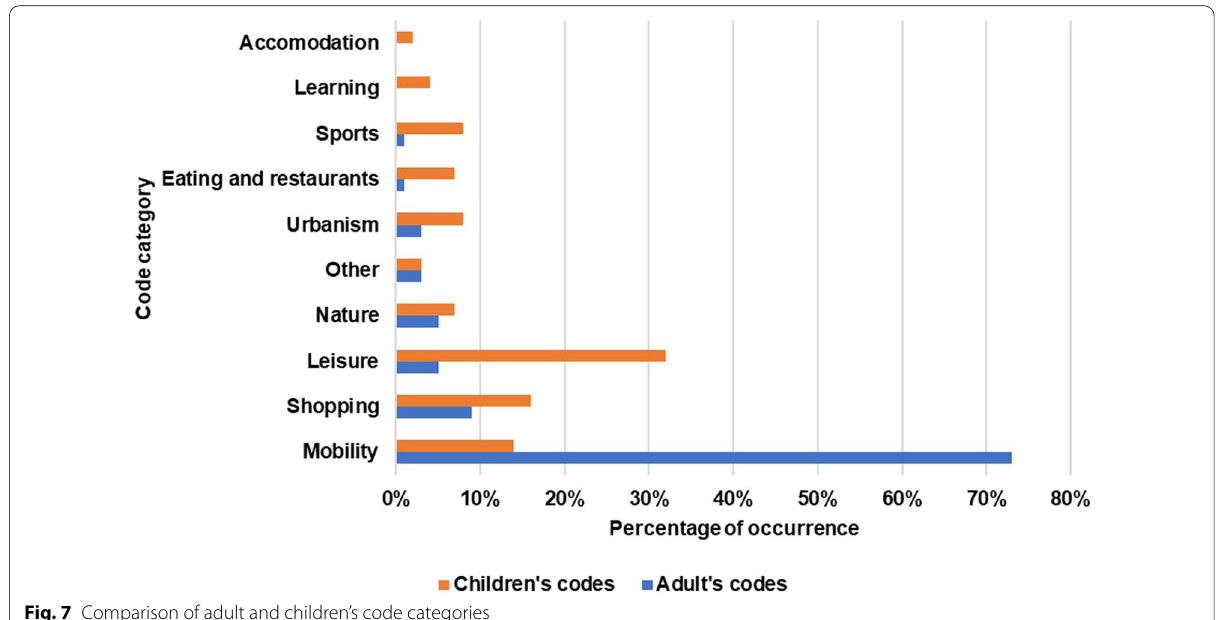
Fig. 7 Comparison of adult and children’s code